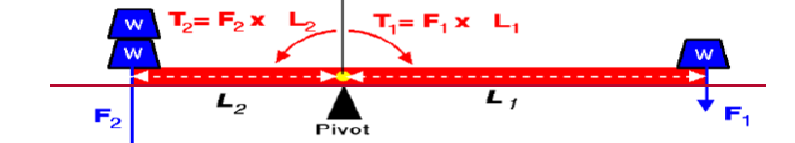
Fig. 2. Torque model in natural physics (Glenn Research Center,